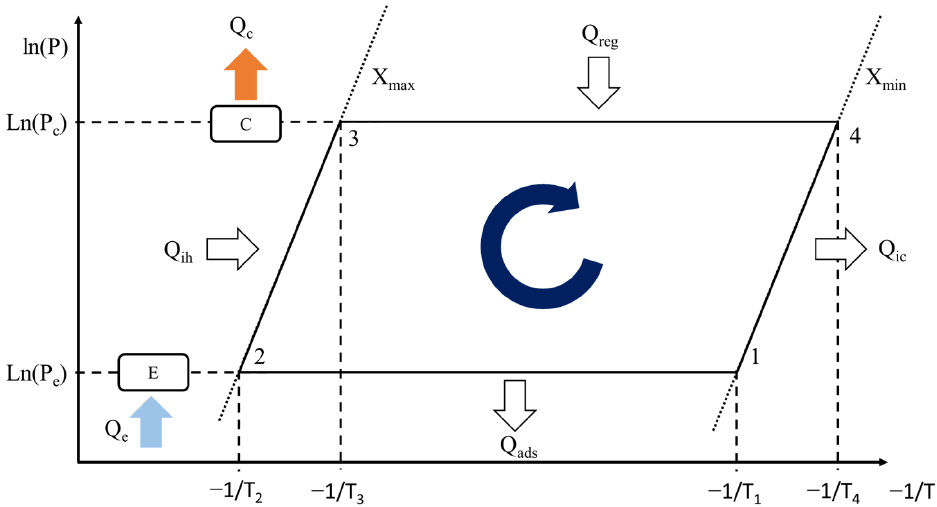
Figure 3. Ideal thermodynamic cycle of the